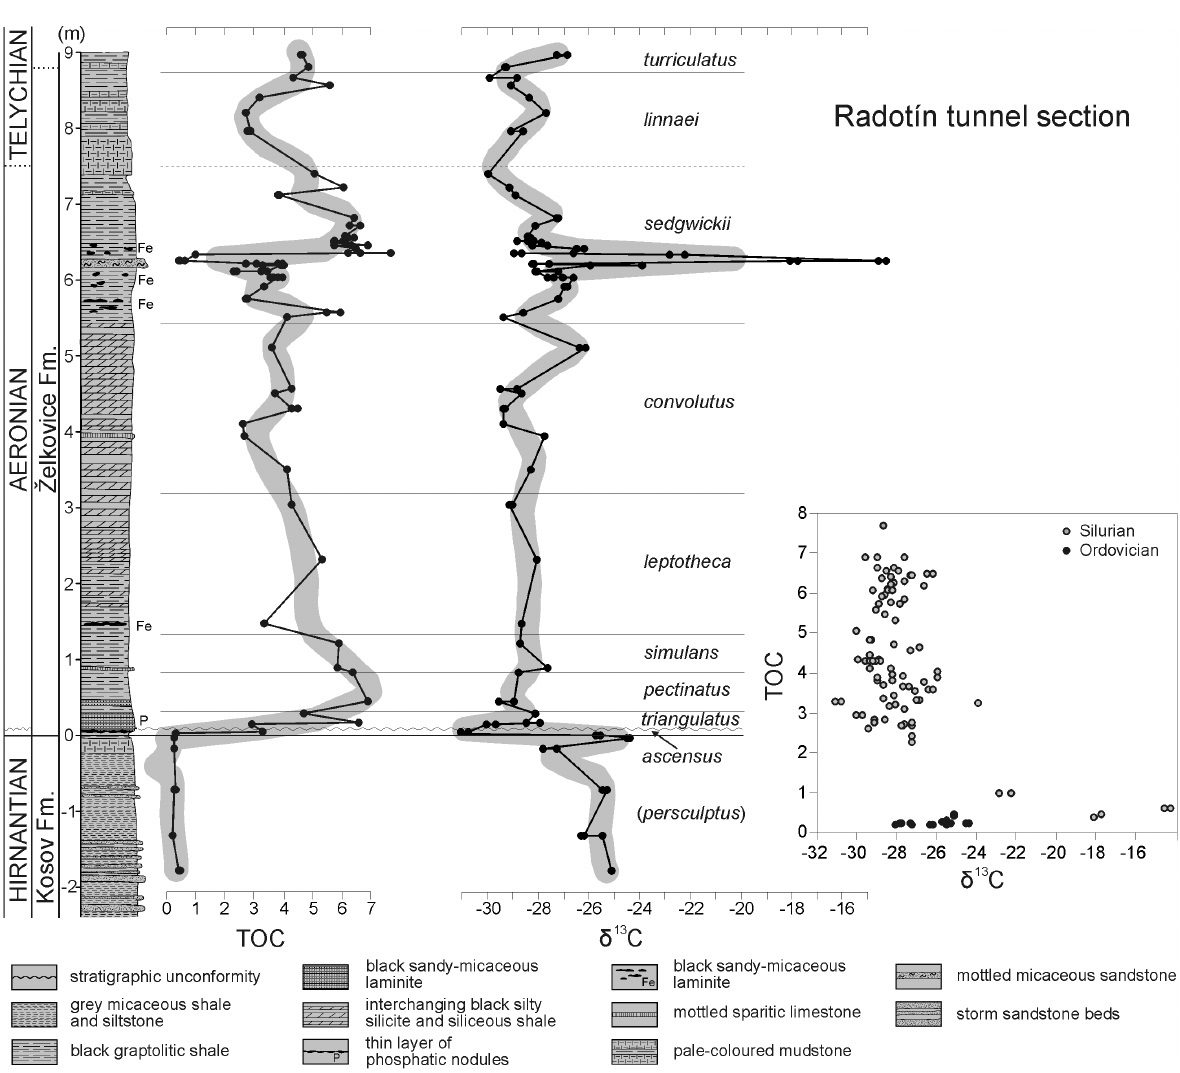
Fig. 2. The δ 13 C org record across the Radot(cid:237)n tunnel section of the Kosov and (cid:142)elkovice formations (Barrandian area; northern peri-Gondwana) and relationship of δ 13 C org ((cid:137) VPDB) and TOC (%) values. The grey line represents locfit